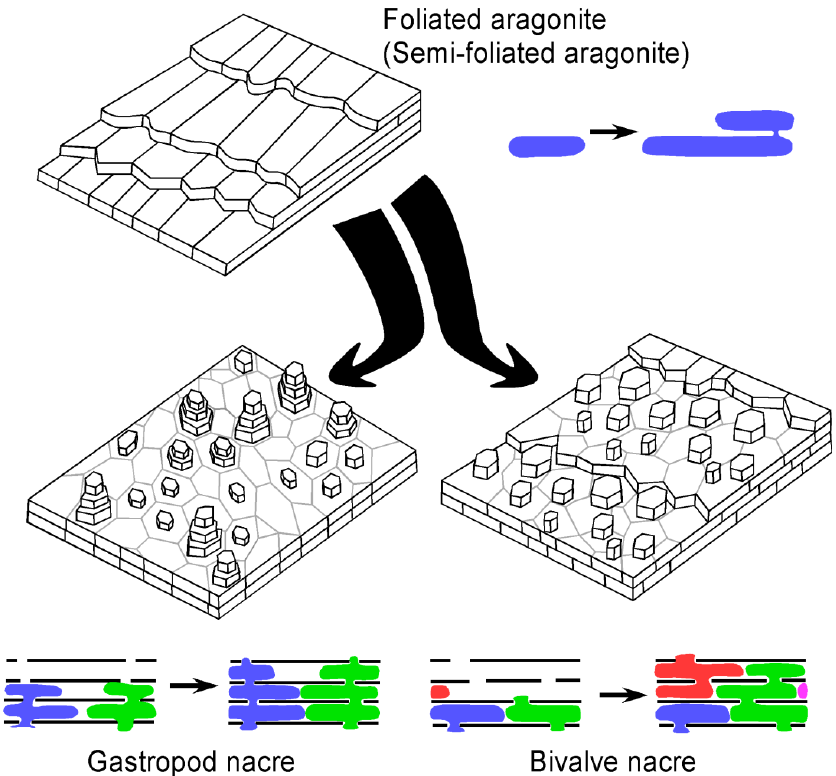
Figure 10. 3-D reconstruction block diagrams and inferred mode of growth of foliated (or semi-foliated) aragonite as well as bivalve and gastropod nacre. The colours represent different aragonite crystals growing through interlamellar membranes. The transformation of foliated (or semi-foliated) aragonite to nacre could have been achieved by addition of a porous interlamellar